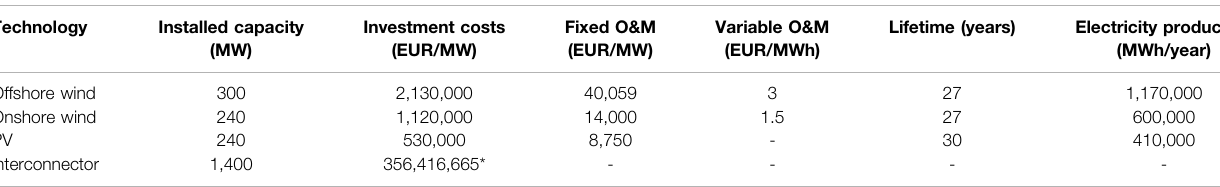
TABLE 4 | Input data for LCOE analysis